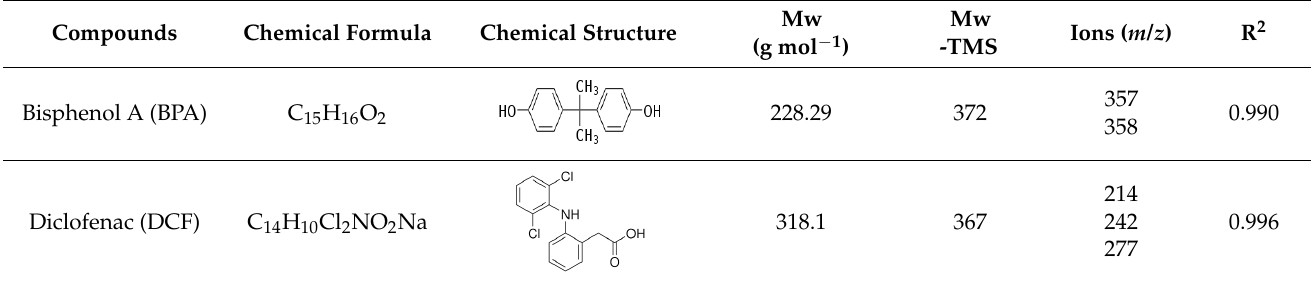
Table 3. Chemical formula/structure, molecular weight, molecular mass of the derivative compounds, quantifier ions ( m/z ), and correlation coefficient (R 2 ) of the target